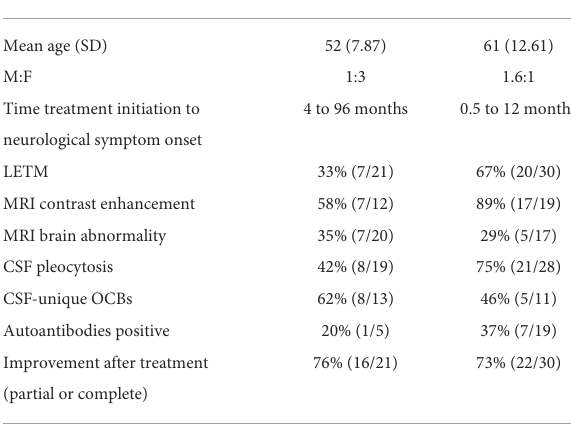
TABLE 1 Summary of main clinical and diagnostic findings in myelitis associated with TNFI and